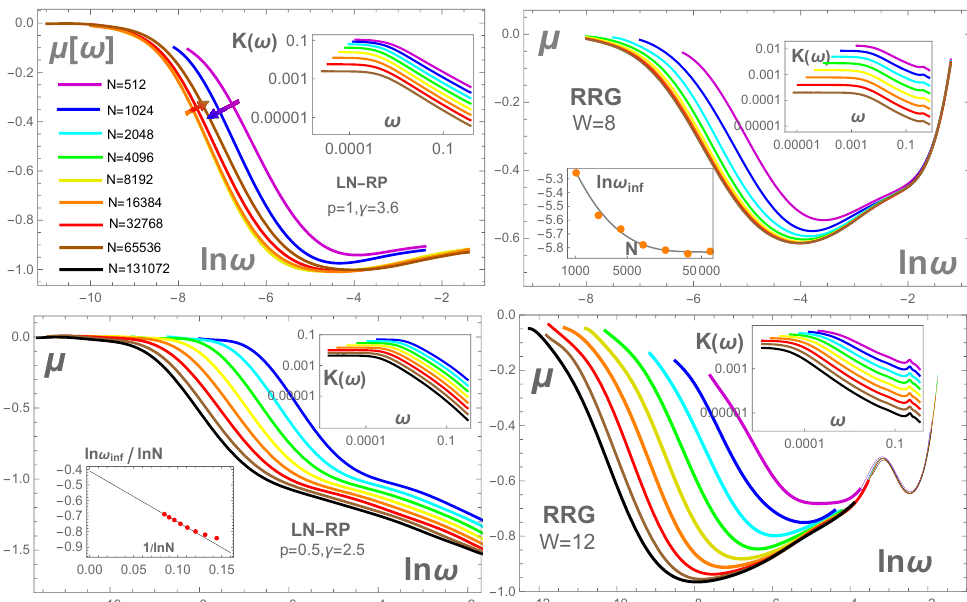
Figure 9: (Color online) The eigenstate overlap correlation function K ( ω ) , Eq. (54) and its log-log derivative (the “running power”) µ ( ω ) , Eq. (56) . (Upper- Left panel): µ ( ω ) for LN-RP model, Eq. (47), with the ACTA symmetry at p = 1 and γ = 3.6 for different matrix sizes N = 512 − 65536. The running power µ ( ω ) interpo- lates between zero at low frequencies and µ ≈ − 1 at the minimum. The dependence on the system size shows a re-entrant behavior with the direction of evolutions shown by arrows. It reflects the reduction of the characteristic energy scale E at small sys- 0 ∼ E tem sizes due to the finite-size multifractality and the growth of E with N BW 0 at large system sizes due to N -dependence of the total spectral bandwidth E (for BW ≈ W / 2 is size-independent). (Upper-Right panel) : µ ( ω ) in the Ander- RRG E BW son model on RRG with W = 8. Lower inset: the evolution of the inflection point on the main plot with increasing the system size. The main plot and this evolution show convergence to the N = ∞ limit. The “low-energy” part ln ω < 2 is similar to that for LN-RP model on the upper-left panel. In the limit N → ∞ we expect both curves to be identical in their low-energy parts if time is measured in units of the corresponding E − 1 . (Lower-Left panel) µ ( ω ) for LN-RP model ( p = 0.5, γ = 2.5) BW without the ACTA symmetry in its multifractal phase for N = 1024 − 131072. The curve for µ ( ω ) does not show a minimum as a function of ln ω but rather a bending point at the level of − 1. Lower inset: the evolution with N of the inflection point on ∼ N − 0.4 in the limit of very large N . the main plot. It approaches the power-law E 0 The characteristic scale E decreases in the multifractal phase due to the reduction 0 of the width of a mini-band. (Lower-Right panel) : µ ( ω ) for RRG at W = 12. The “low energy” part ln ω (cid:174) − 4 is similar to that in ’symmetric’ LN-RP on the upper-left panel, though the convergence to the thermodynamic limit N → ∞ is much slower and does not show re-entrance at system sizes studied. The “high-energy” part at ln ω (cid:166) − 4 is system specific and N -independent. The low-energy part ln ω < − 4 was Fourier-transformed to obtain the stretch-exponential behavior on the upper-right panel of Fig. 8. (Upper insets) in all panels show K ( ω ) for the same parameters as the main panels. The color code (from purple to black) of the curves for system sizes N = 512, 1024, 2048, 4096, 8192, 16384, 32768, 65536, 131072 is the same on all the plots and given by the legend in the upper left